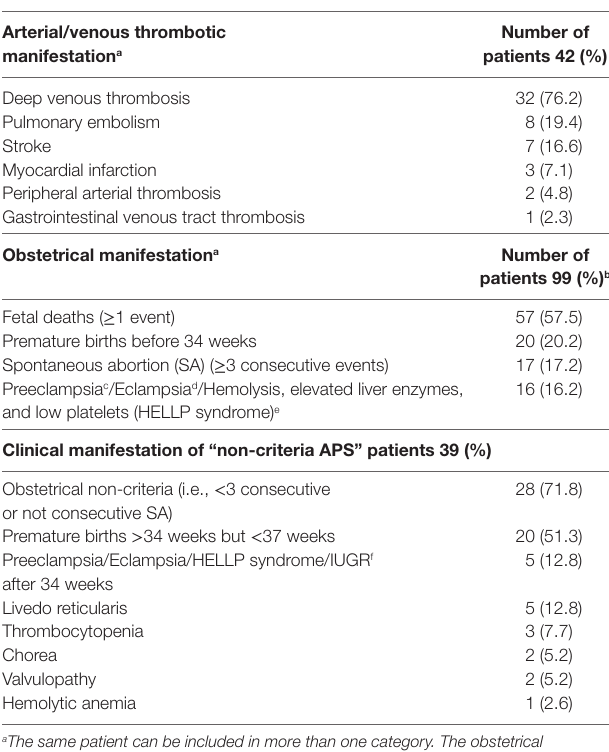
Table 1 | Clinical criteria manifestations at study onset.